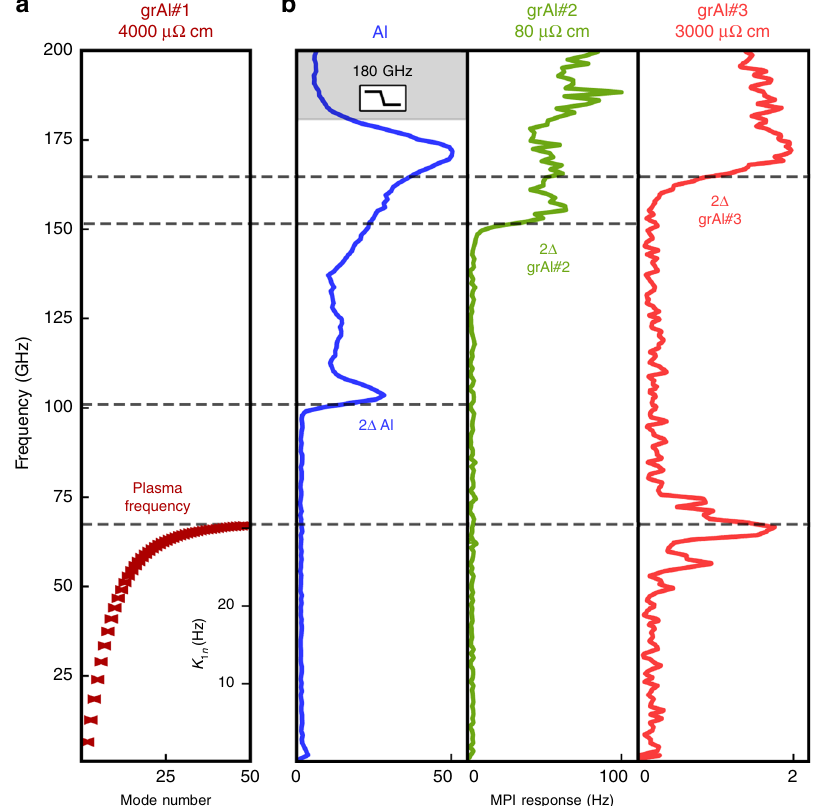
Fig. 4 Measurement of the dispersion relation in grAl resonators. a Calculated dispersion relation f ( n ) for resonator grAl#1 starting from two-tone measurements of the third mode (see text). The spectrum saturates at the effective plasma frequency 68 ± 0.1 GHz. From Eq. (4), the cross-Kerr coef fi cients follow the dispersion relation, and their values are reported on the right axis. A signi fi cant cross-Kerr coupling enables the observation of the high-frequency spectrum up to the effective plasma frequency: photons populating the high end of the spectrum shift the low-lying eigen frequencies, which can be monitored via standard RF transmission measurements (see Fig. 2d). b Martin – Puplett Interferometer (MPI) response of Hilbert-shaped resonators made of 25-nm-thick Al, grAl with resistivity 80 μΩ cm (grAl#2), and grAl with resistivity 3000 μΩ cm (grAl#3). The illumination frequencies generated by the MPI range from a few GHz up to 200 GHz, with a resolution of 1 GHz. The different superconducting gaps of the fi lms are evidenced by a strong MPI response due to quasiparticle excitation at 100 GHz for Al, at 150 GHz for grAl#2, and at 165 GHz for grAl#3. For the sample with the highest resistivity and the lowest critical current density, grAl#3, we observe a peak around 65 GHz, in the vicinity of the ω p predicted from low-frequency measurements on sample grAl#1, with a similarly high resistivity (4000 μΩ cm, see text for details). This MPI response can be seen as the summed dispersive frequency shift due to cross-Kerr interactions K 1 n between the fundamental mode and all higher populated